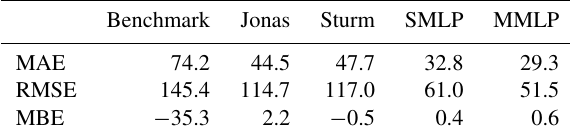
Table 7. Performance evaluation of the model with a single MLP ensemble covering Canada (SMLP) and the multiple MLP ensem- bles (MMLP), evaluated using the testing data set.